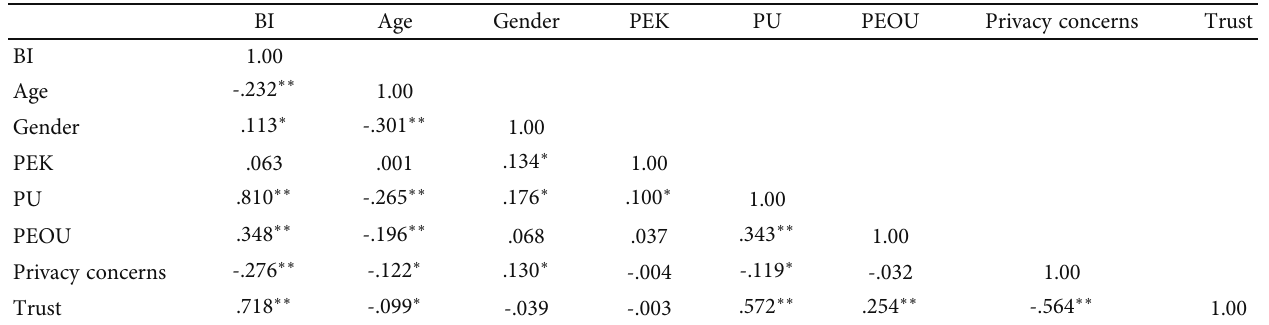
Table 4: Pearson correlation coe ffi cients of online banking scales.